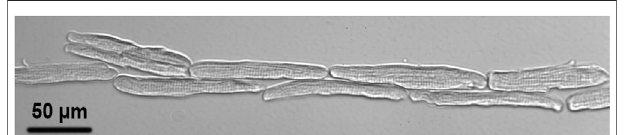
FIGURE 3 | A typical laser patterned adult cardiomyocyte culture imaged with the patterning microscope after 30 min culture in the on-stage incubator upon completion of the pattern.